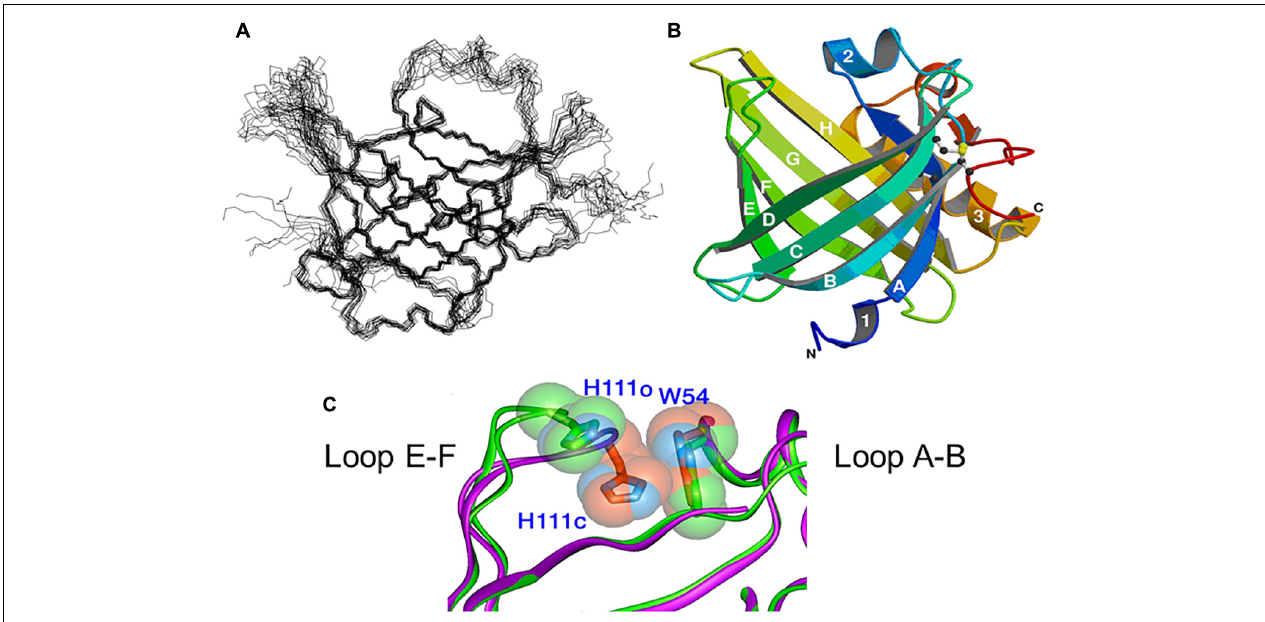
FIGURE 2 | NMR (A) and X-ray crystallographic (B) structures of L-PGDS (Shimamoto et al., 2007; Kumasaka et al., 2009, respectively). (C) Overlapping views of the entrance of the catalytic pocket of the open ( green ) and closed ( purple ) conformers of L-PGDS (Kumasaka et al., 2009). Positions of EF-loop and H2-helix are